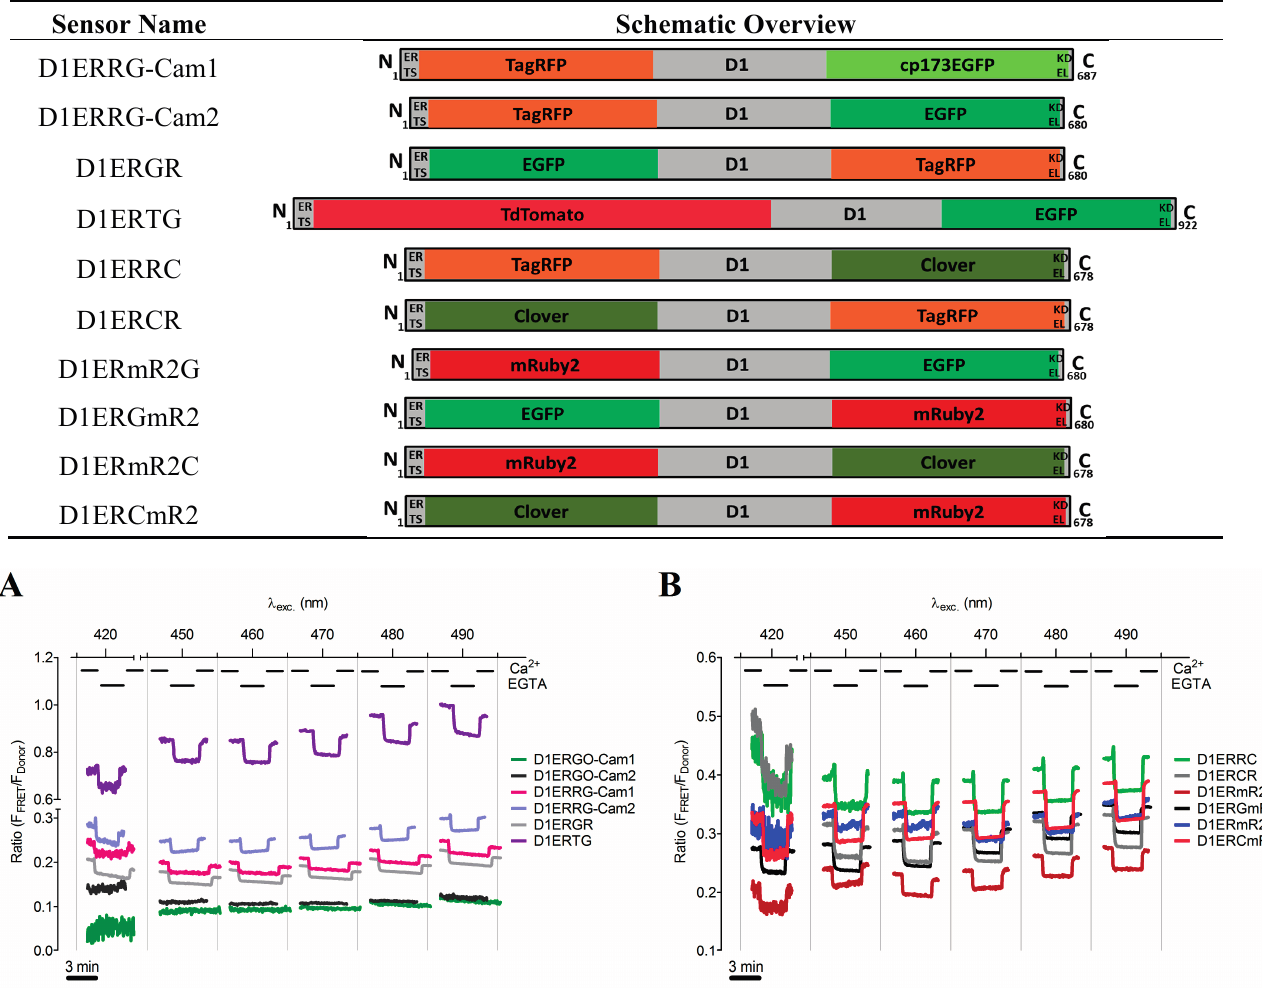
Figure 2. Functional evaluation of red-shifted cameleons in the ER. Permeabilized HeLa cells transfected with individual red-shifted sensors targeted to the ER were recorded in an extracellular Ca 2+ -free solution and in a 2 mM Ca 2+ containing environment, respectively. Representative curves showing FRET signals of each indicator excited at 420, 450, 460, 470, 480 or 490 nm and emissions were collected from either ( A ) D1ERGO-Cam1 (dark grey curve), D1ERGO-Cam2 (green curve), D1ERRG-Cam1 (pink curve), D1ERRG-Cam2 (purple curve), D1ERGR (light grey curve), D1ERTG (violet curve) or ( B ) D1ERRC (light green curve), D1ERCR (grey curve), D1ERGmR2 (black curve), D1ERmR2G (dark red curve), D1ERmR2C (blue curve) or D1ERCmR2 (red